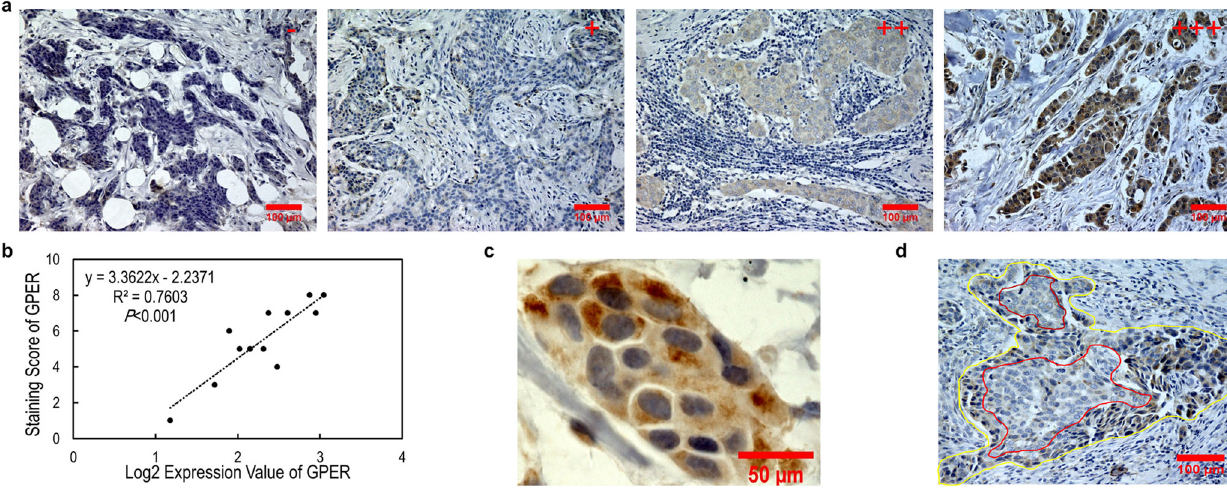
Fig. 1 Immunohistochemical staining for GPER. a Immunohistochemical staining for GPER with different intensity. The staining is graded as negative ( − ), weak ( + ), moderate ( ++ ), and strong ( +++ ). Scale bar, 100 μ m. b Scatter plots show that the IHC score is linearly correlated with the log2 expression value of GPER in the results of Pearson correlation coef fi cient calculation, which is statistically signi fi cant. Pearson correlation coef fi cient R 2 and p -value are given in the scatter plot. c Image showing IHC staining of GPER is only observed in cytoplasmic. Scale